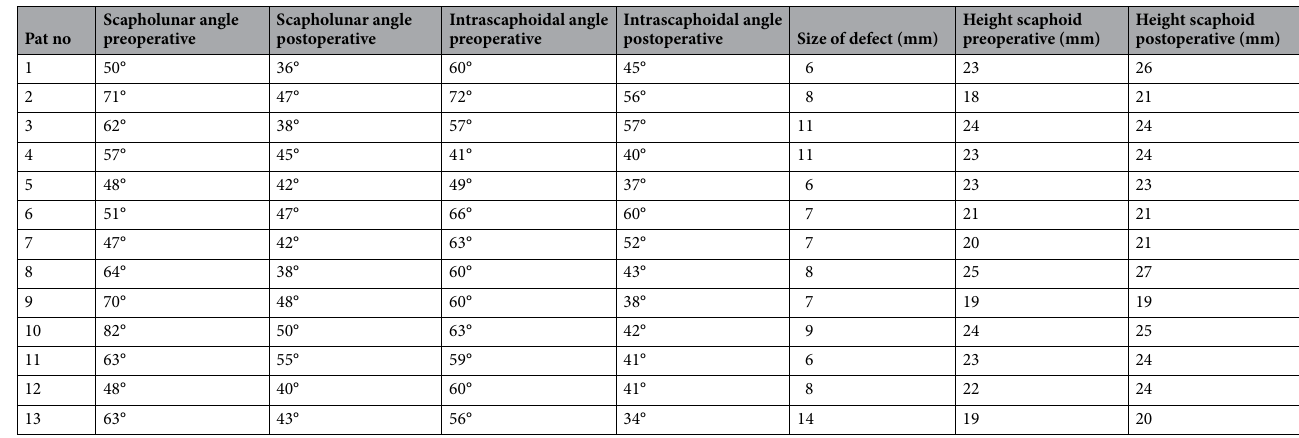
Table 2. Measurements of the scaphoid pre- and